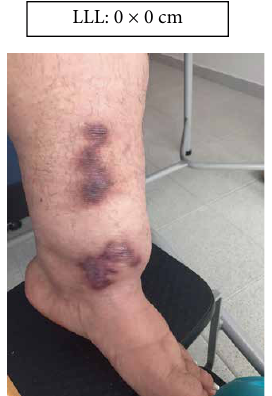
Figure 13: Week 4. Lower right limb.